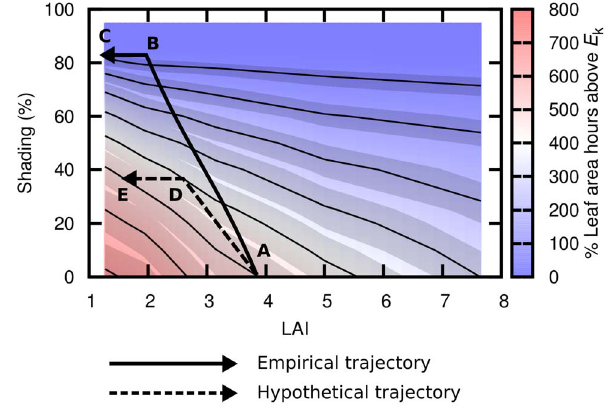
Figure 7. Trajectories of canopies from empirical shading experiment and hypothetical example. Underlying plot is as described in the caption of Figure 6a.